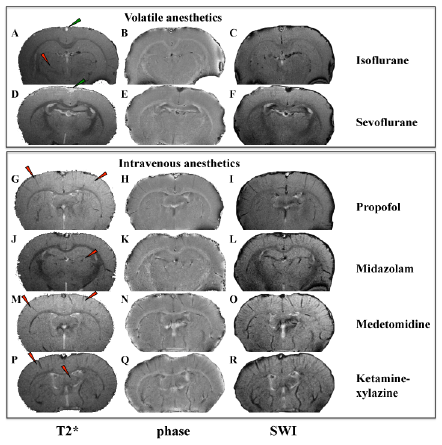
anesthetic agents. T2* magnitude, left panel; T2* phase, middle panel; susceptibility weighted images (SWI), right panel. Red arrowheads refer